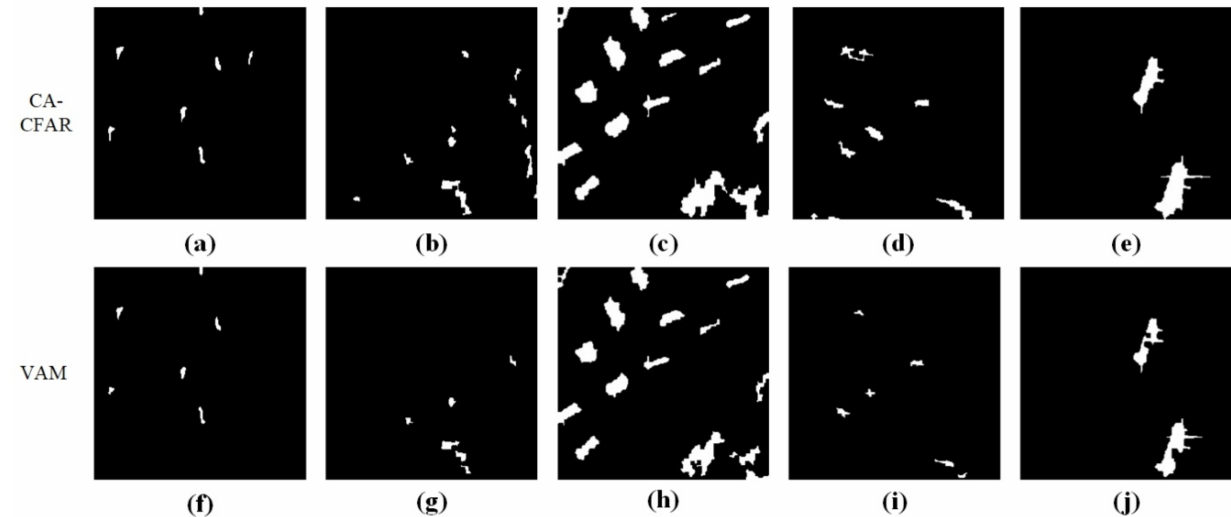
Figure 10. Experimental results on SAR-Ship-Dataset. ( a – e ) The first row contains the results of CA-CFAR. ( f – j ) The second row contains the results of VAM.